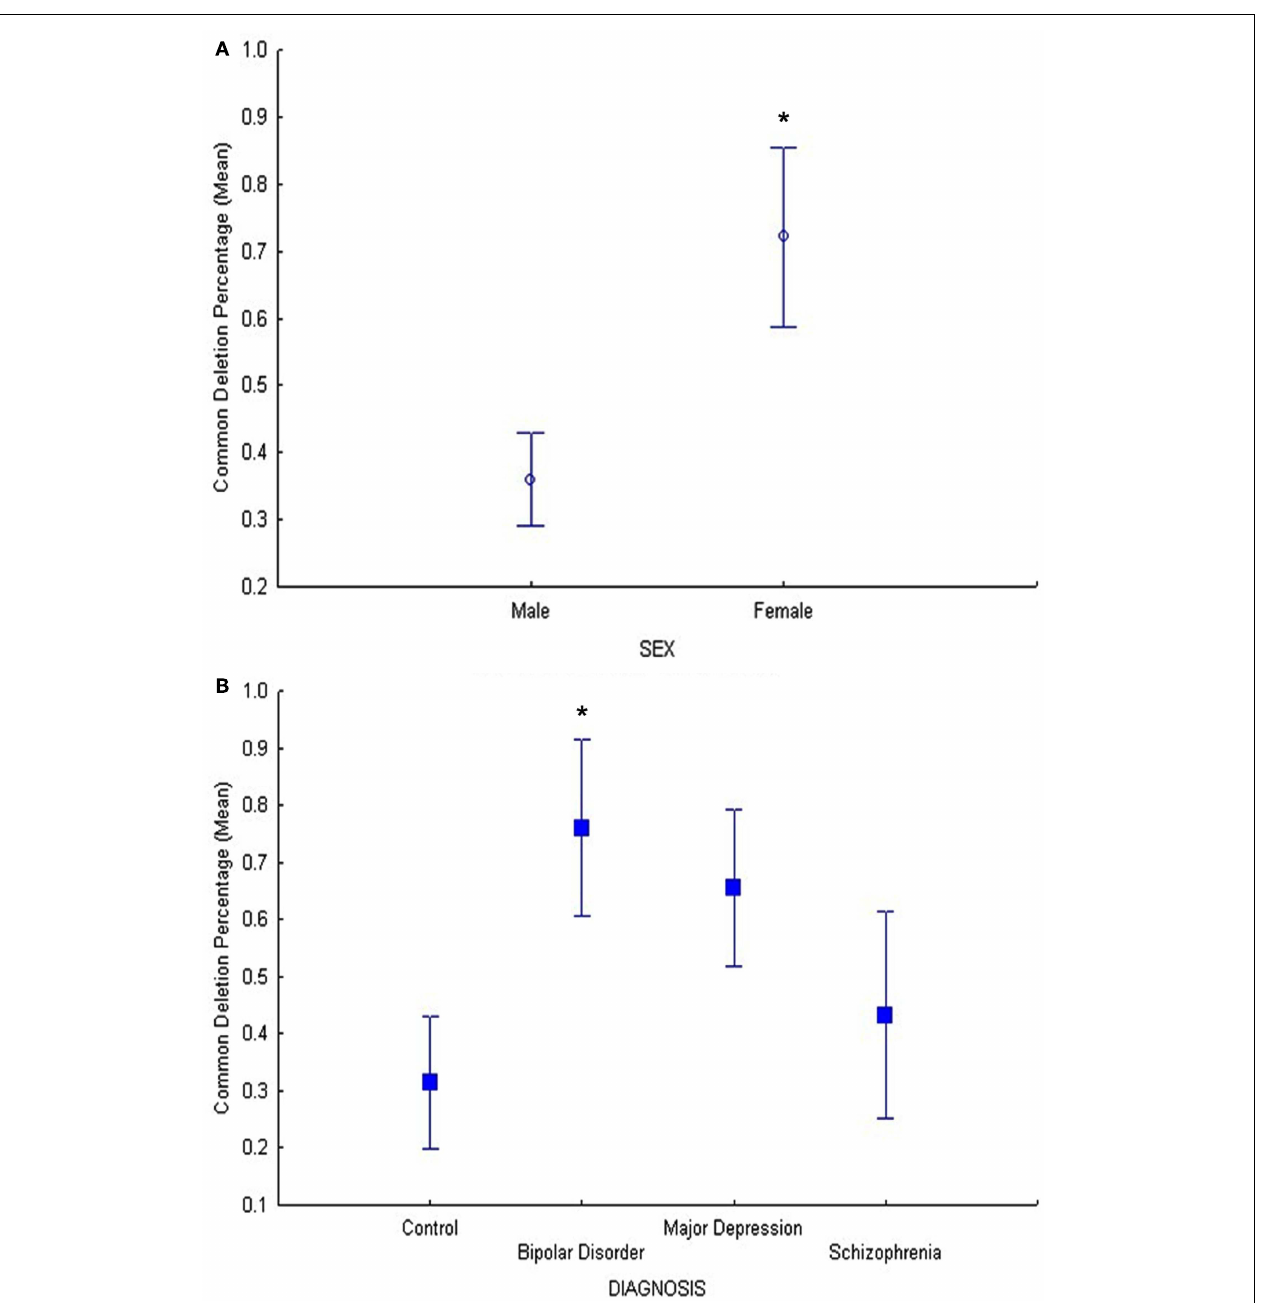
FIGURE 3 | (A) In cohort 2, the main effect of sex was significant ( F = 5.5, p = 0.02) on common deletion percentage in DLPFC, with females exhibiting significantly higher percentages of the mitochondrial common deletion compared to males.The age-adjusted means and standard error bars are